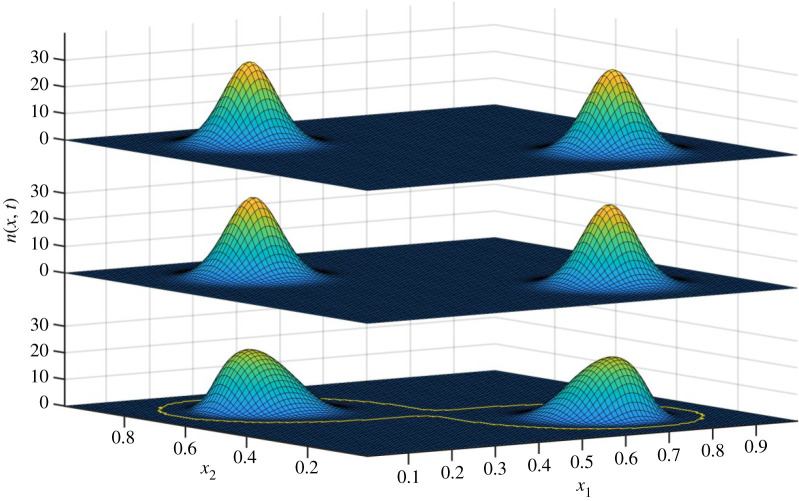
Comparison of two models as in figure 4, but for a case 2, at a time (T = 2000) where two species can be recognized, as described in the text. The bottom level is the PLM, and the middle layer is the species-level interpretation of PLM in terms of two species. The top level is the SLM with two species. The yellow line delimits the region within which n(x, T) > 0, i.e. the domain of D1(T): we see that even at this state of divergence, the assumption of two independent species is not (yet) fully justified.